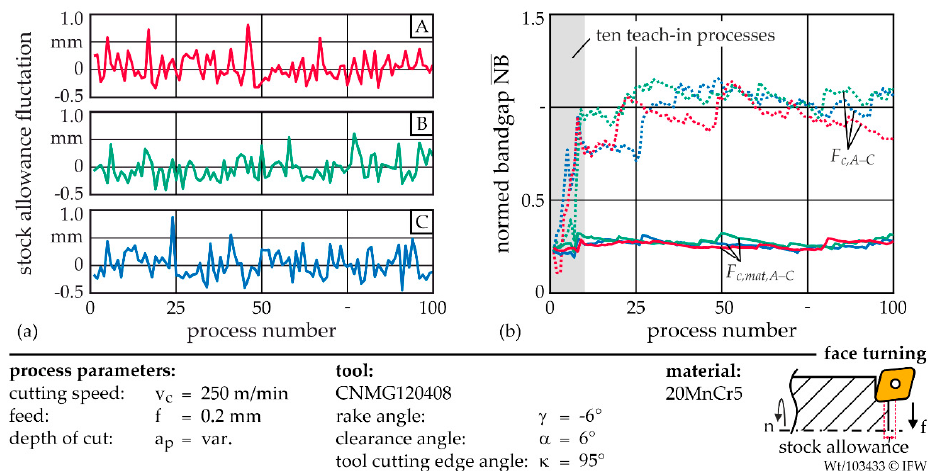
Figure 4. ( a ) Distribution of three process series with different stock allowance variation and ( b ) evolution of normed bandgaps for one hundred facing operations per series.